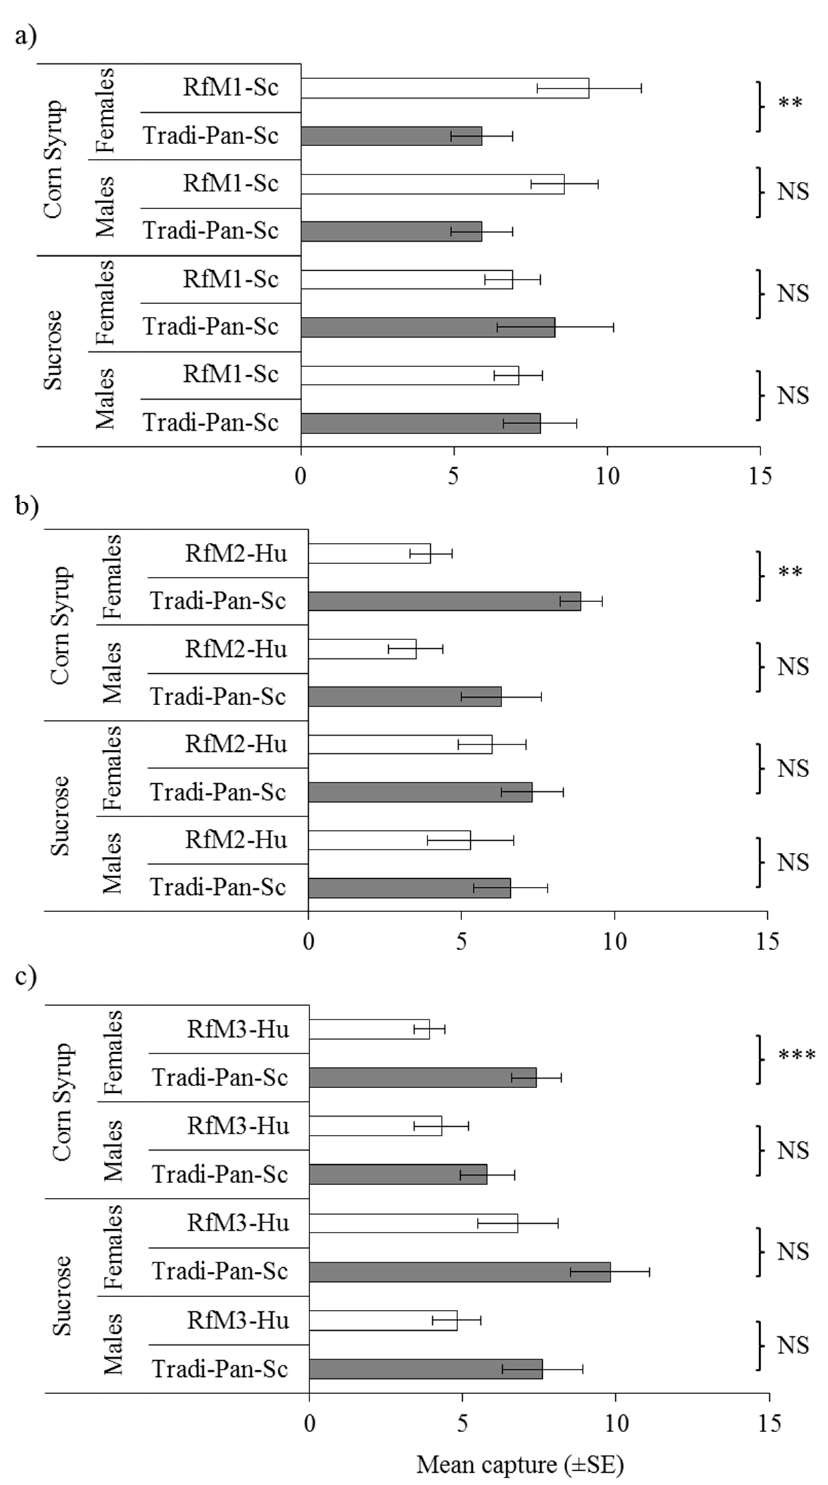
Figure 2. Mean numbers of trapped males and females in pairwise comparisons of blackberry isolated yeasts; ( a ) Saccharomyces cerevisiae, RfM1-Sc, ( b ) Hanseniaspora uvarum , RfM2-Hu, and ( c ) H. uvarum , RfM3-Hu with the reference baker’s yeast S. cerevisiae (Tradi-Pan-Sc) when grown in sucrose or corn syrup. NS indicates no significant di ff erence p > 0.05; ** denotes significant di ff erence p < 0.05; *** p < 0.001, (paired t -test).